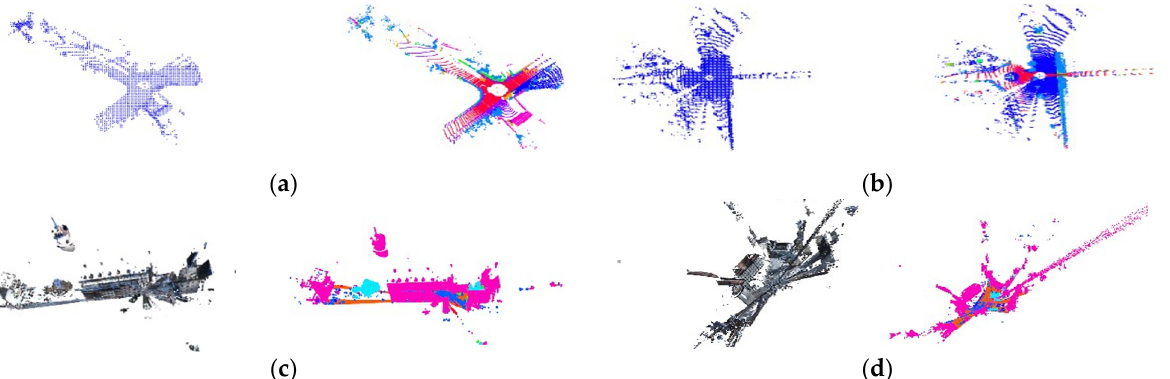
Figure 12. The segmentation effect on different datasets: ( a ) frame-by-frame segmentation effect of SemanticKITTI-11; ( b ) frame-by-frame segmentation effect of SemanticKITTI-12; ( c ) panoramic split effect of Semantic3D-1; and ( d ) panoramic split effect of Semantic3D-2.